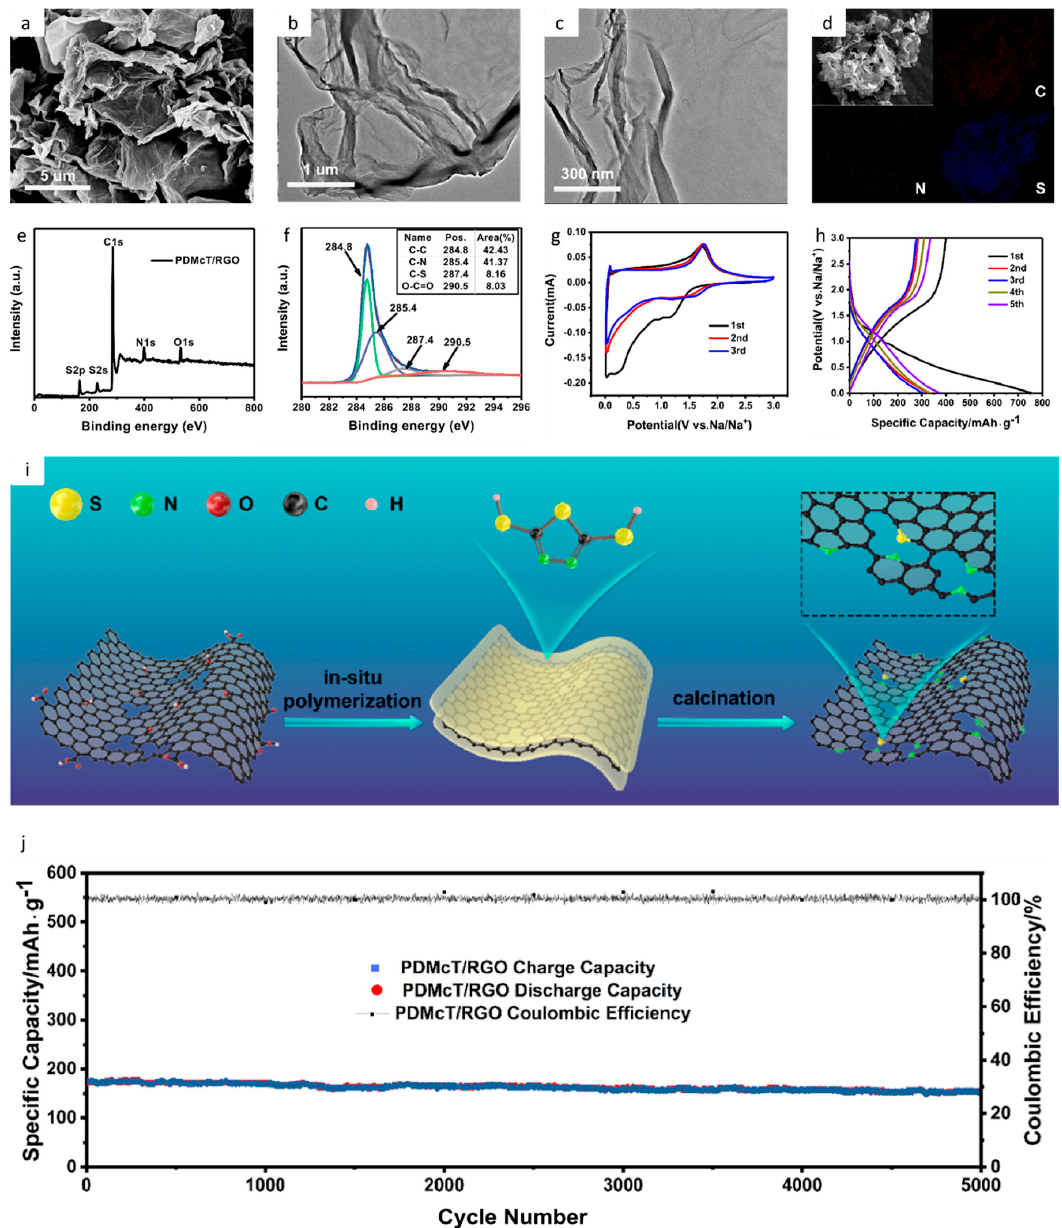
Figure 7. Characterization and electrochemical performance analysis of poly(2,5-dimercapto-1,3,4- thiadiazole)(PDMcT) / reduced graphene oxide (RGO) (PDMcT / RGO) as an anode in SIBs: ( a ) scanning electron microscopy (SEM) of the material, ( b , c ) transmission electron microscopy (TEM) of the material, ( d ) energy dispersive X-ray (EDX) elemental mapping of the material indicating the homogeneous distribution of atoms N, and S co-doping the graphene sheets, ( e ) X-ray photoelectron spectroscopy (XPS) survey of the material corroborating the results obtained at EDX, ( f ) high resolution XPS of C 1s showing the C-C, C-N, and C-S characteristic binding energies, ( g ) cyclic voltammetry curves from 1st to 3rd cycles for voltage range from 0.01–3.0 V at scan rate of 0.1 mV s − 1 . In the 1st cycle, at approximately 0.2 V, the reduction peak may be assigned to the solid-electrolyte interphase (SEI) formation; additionally, at approximately 0 and 0.09 V, redox peaks may be assigned, respectively, to Na + insertion / extraction from graphene layers, ( h ) charge and discharge curves at current density of 50 mA g − 1 , ( i ) representation of the synthesis of the material PDMcT / RGO, and ( j ) specific capacity representation versus cycle number for current density of 5000 mA g − 1 showing the low drop in capacity even after 5000 cycles; thus, remaining at 153.3 mAh g − 1 . Reprinted with permission from [155]. Copyright 2018, American Chemical